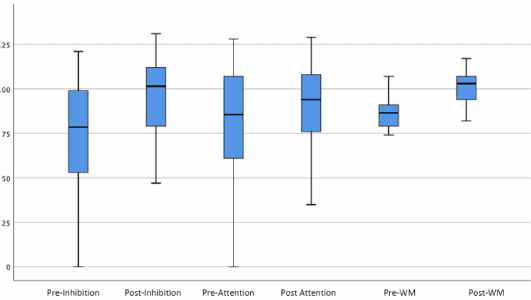
Figure 2. The mean in standard score pre- and post-training for the inhibition, attention, and overall working memory